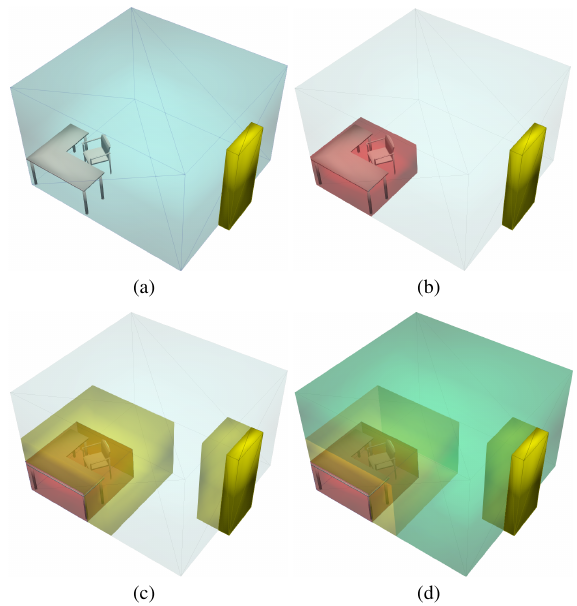
Figure 4. Example of the FSS implementation on a simple 3D room model scenario. (a) Room space (light blue) with a chair, a desk and a door (yellow). (b) O-Space encapsulating the furniture. (c) F-Spaces (yellow) of the O-Space and the door. (d) R-Space (green) of the